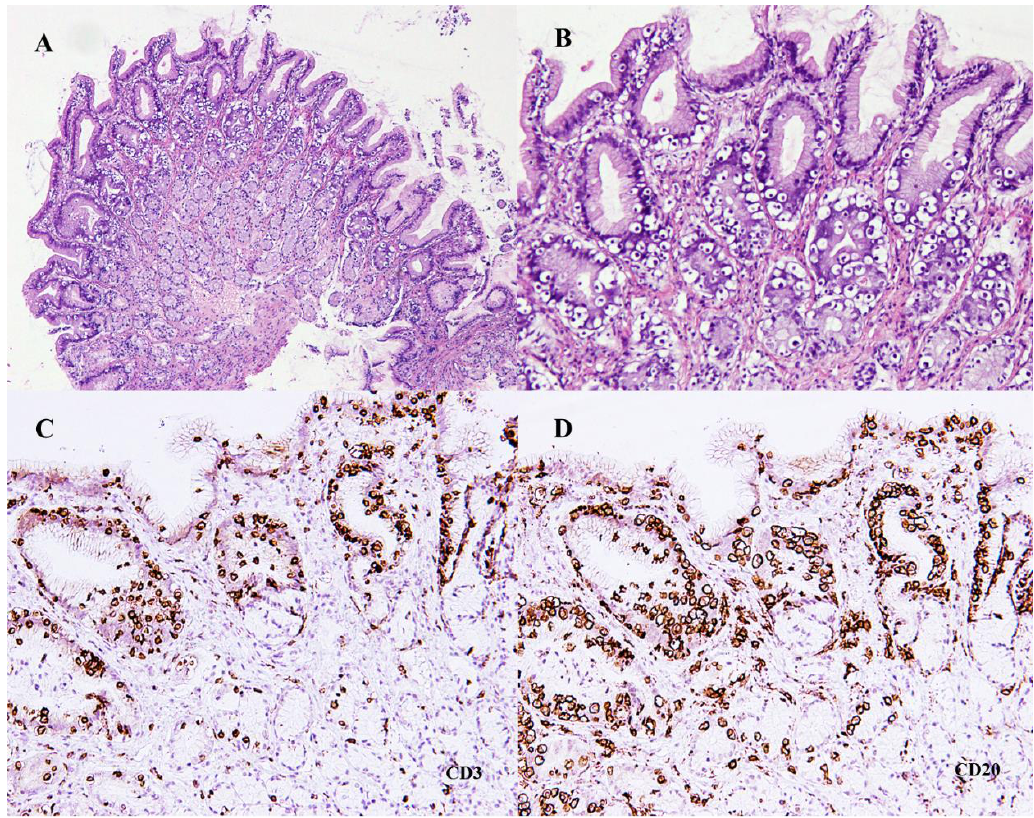
Figure 1. ( A , B ) Microphotographs of endoscopic biopsies of gastric pyloric mucosa showing infil- tration of the superficial epithelium and one of the crypts by small lymphocytes (H&E, ( A ) ×40 and ( B ) ×100). ( C , D ) Immunohistochemistry for lymphoid T-cells ( C ) (anti-CD3) and B-cells ( D ) (anti- CD20) (Mayer ’ s hematoxylin, ×100).